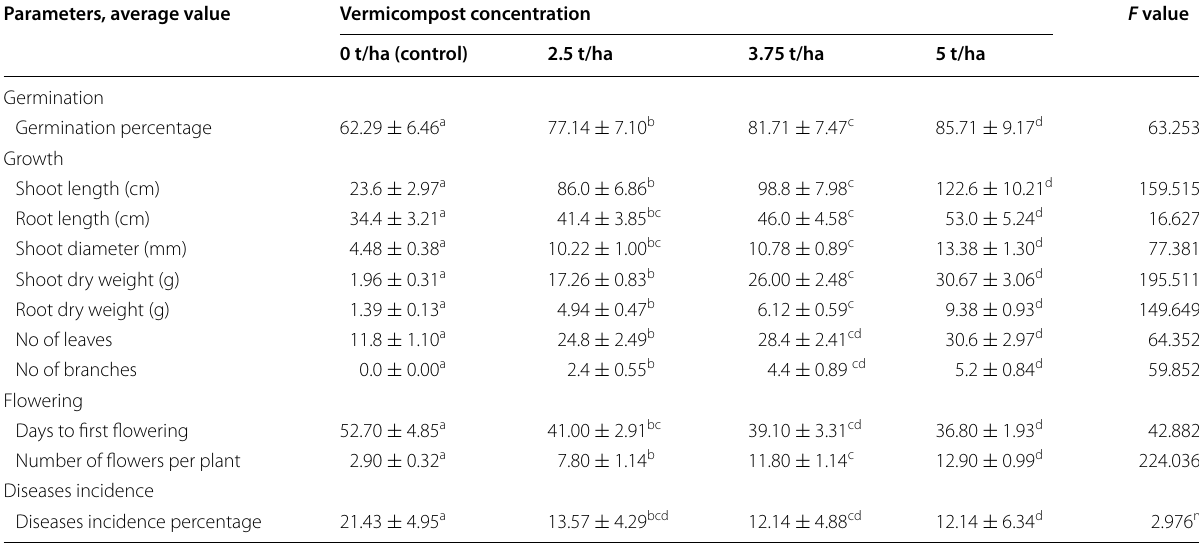
Table 1 Seed germination, plant growth, flowering, and disease incidence in ladies finger plants grown in soil fortified with different concentrations of parthenium vermicompost